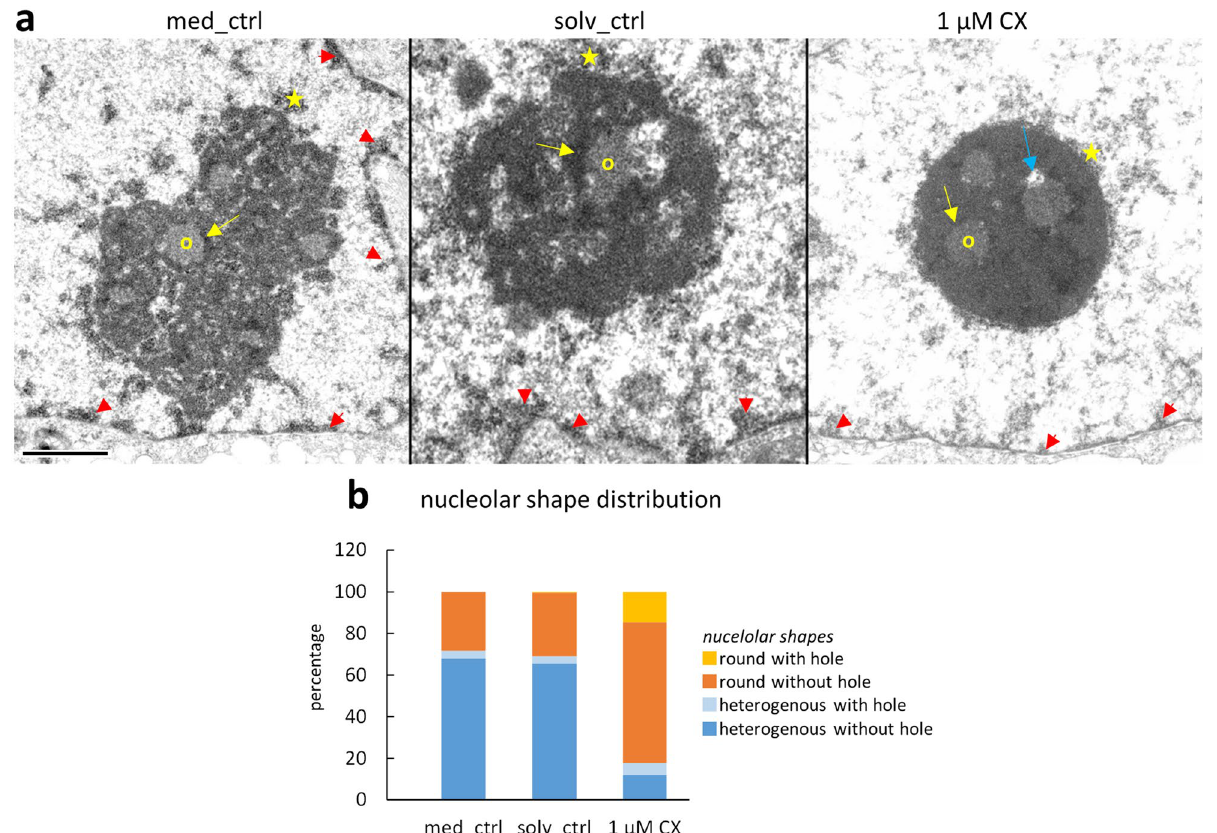
Figure 4. Ultrastructural changes in nucleoli of Hep3B cells treated with CX-5461. ( a ) Representative EM images; left: medium control nucleolus with typical heterogeneous, decompacted shape and several FCs (an example indicated with yellow O) surrounded by DFC (yellow arrow); patches of perinucleolar condensed chromatin (yellow star) are visible. Middle: solvent control nucleolus displays similar architecture as in medium control. Right: typical nucleolus after exposure to 1 µM CX-5461 for 1 h. Note compacted and rounded nucleolus and intranucleolar “holes” visible between FCs and DFCs (blue arrow); the perinucleolar chromatin is present as a continuous layer around the nucleolus (yellow star); the remnant nucleoplasm is less heterochromatic including the nuclear lamina (red arrowheads); ( b ) counting of nucleolar shapes on semi-thin sections (percentages) demonstrates the significant increase (P < 0.001 for both “with” and “with-out” hole) of the round, compacted shape upon CX-5461 treatment (a mean of 345 nucleoli per category was counted in 1 experiment). Bar = 1